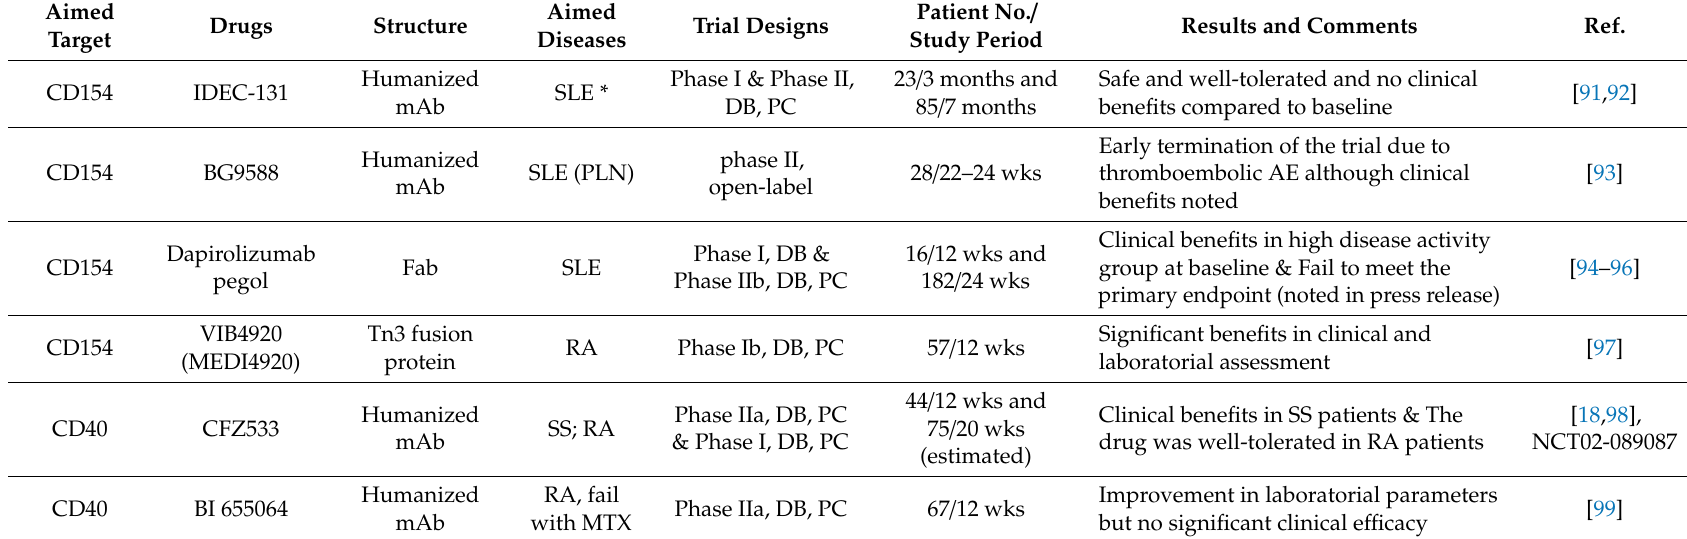
Table 1. Clinical experience with pivotal CD40-CD154 blockers for patients with rheumatic autoimmune